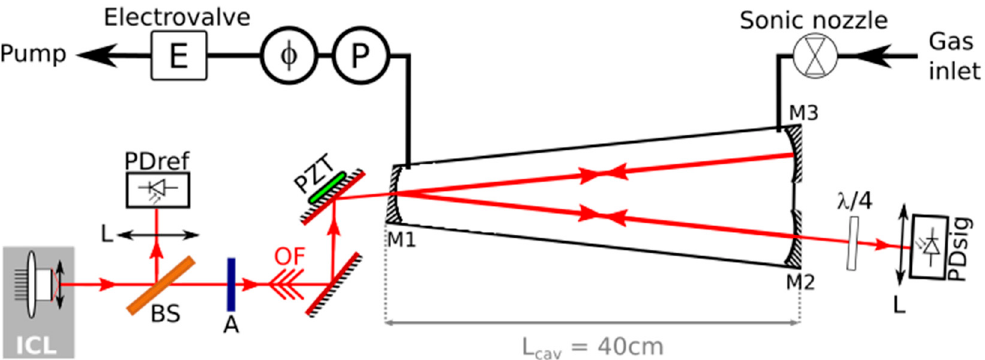
Figure 1. Experimental scheme of the Optical-Feedback Cavity Enhanced Absorption Spectroscopy (OF-CEAS) analyzer, using an ICL at 5.3 µm for nitric oxide (NO) detection. The V-cavity is made of three mirrors (M1, M2, and M3). A ZnSe beam splitter (BS) is used to monitor the laser power with the photodiode PDref. A glass microscope slide is used as an attenuator (A) to adjust the OF rate. OF phase is controlled by acting on a piezoelectric element (PZT) supporting one of the steering mirrors. A quarter-wave plate ( λ /4) is used to minimize back reflection effect from the photodiode monitoring cavity transmission (PDsig). Pressure (P) and flux ( φ ) of the flowing gas are controlled.